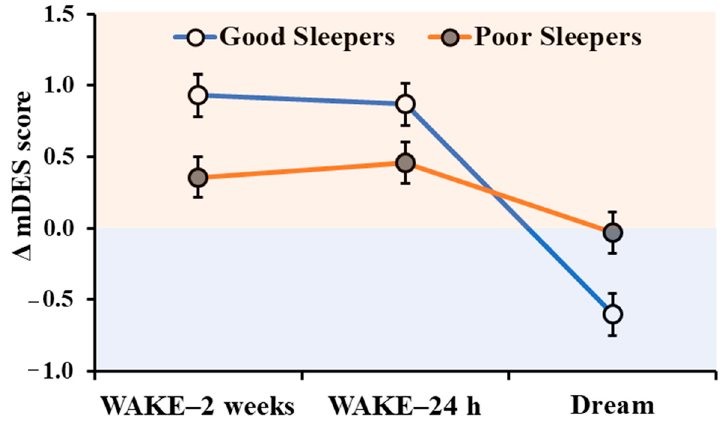
Figure 6. Change in ∆ mDES scores (PA minus NA) as a function of condition (WAKE-2 weeks, WAKE-24 h, and DREAM) in Good and Poor Sleepers. The orange area indicates positive affect and the blue area indicates negative affect. Error bars represent standard error of the means. Table 1. Mean and standard error of ∆ scores in the two groups across conditions. Good Sleepers Poor Sleepers p (holm)